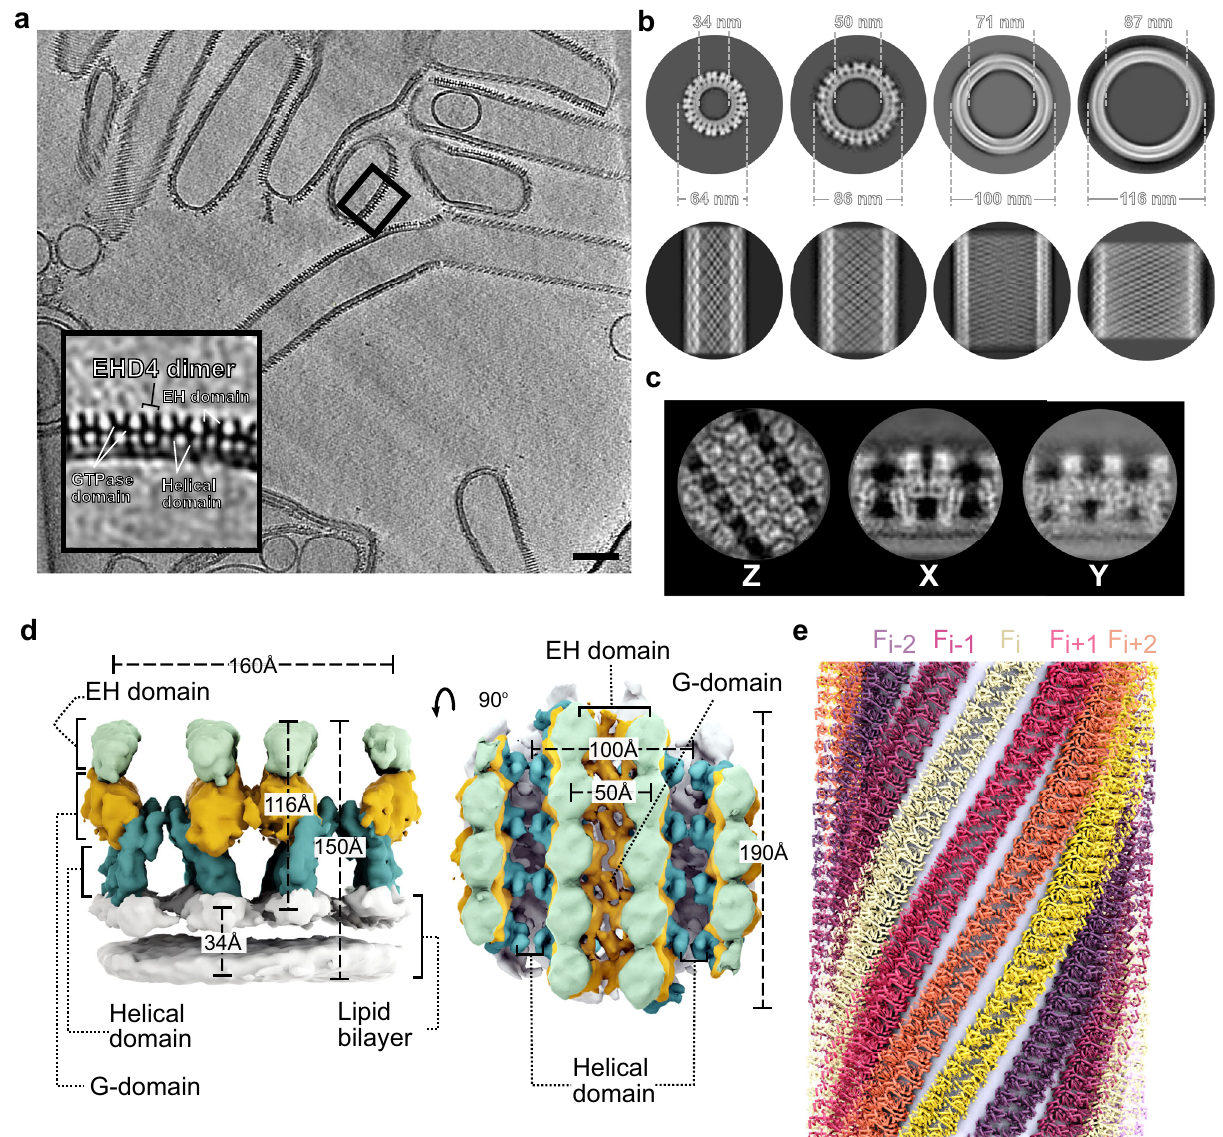
c Projectionsofthe membrane-bound mapusing 23,813particles. d Subtomogram average of the membrane-bound EHD4 Δ N complexed with AMPPNP at 7.6Å reso- lution. Domain organization of EHD4 in the fi laments in two orientations isshown. EH domains (light green), G-domains (orange), helical domains (teal) and the lipid bilayer(white)arecoloredindividually. e ReconstructedEHD4right-handedhelical fi laments wrapping around a membrane tube. Each fi lament is indicated in a different